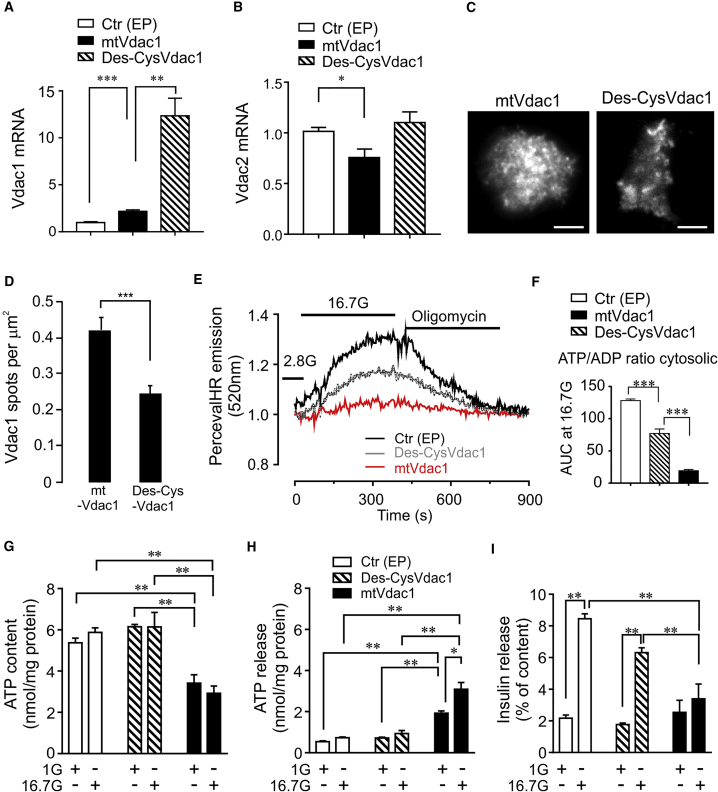
Overexpression of desCys(127/232)VDAC1 (Des-CysVDAC1) Is Less Harmful for INS-1 Cell Function than mtVDAC1(A and B) Vdac1 mRNA expression (A) and Vdac2 mRNA expression (B) in cells transfected with mtVdac1 or Des-CysVdac1. Results are mean ± SEM of four independent experiments with 1–4 replicates in each.(C) Representative image of plasma membrane-near localization of mtVdac1 or Des-CysVdac1 in INS-1 cells assessed by total internal reflection fluorescence microscopy. Scale bar indicates 5 μm.(D) Surface density of mtVdac1 and Des-CysVdac1 in INS-1 cells; Mean ± SEM of 30 cells each from three independent experiments.(E) Cytosolic ATP/ADP ratio measured in single INS-1 cells (Ex/Em 488/520, 37°C) by confocal microscopy after co-transfection with PercevalHR and either mtVdac1 or Des-CysVdac1.(F) Glucose-induced increases in cytosolic ATP/ADP ratio are largely preserved in des-Vdac1 and abolished in mtVdac1 overexpressing INS-1 cells. AUC for glucose stimulation of five to ten analyzed cells from six different experiments, for AUC of the values after oligomycin addition (see Figure S6).(G–I) ATP content (G), ATP release (H), and insulin release (I) from INS-1 cells transfected with empty plasmid (Ctr), Des-CysVDAC1, or mtVDAC1 plasmids and incubated at 1 mM (1G) or 16.7 mM glucose (16.7G) for 1 hr (n = 5).